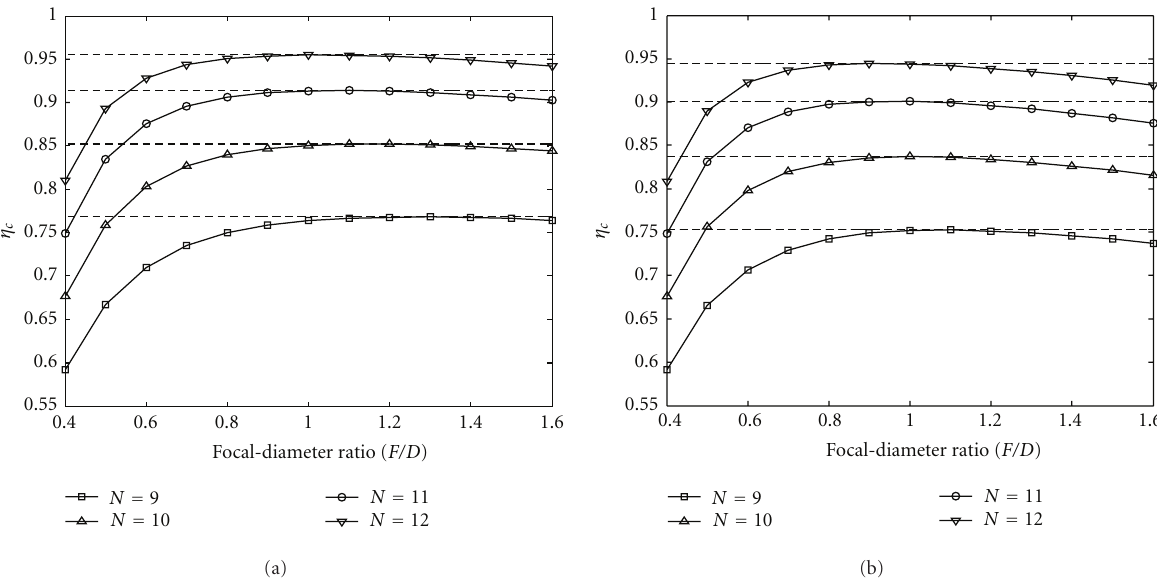
Figure 3: The dependence of radiative collection e ffi ciency η c on F/D ratio with the random surface error σ s of (a) 0 mrad and (b) 10 mrad.